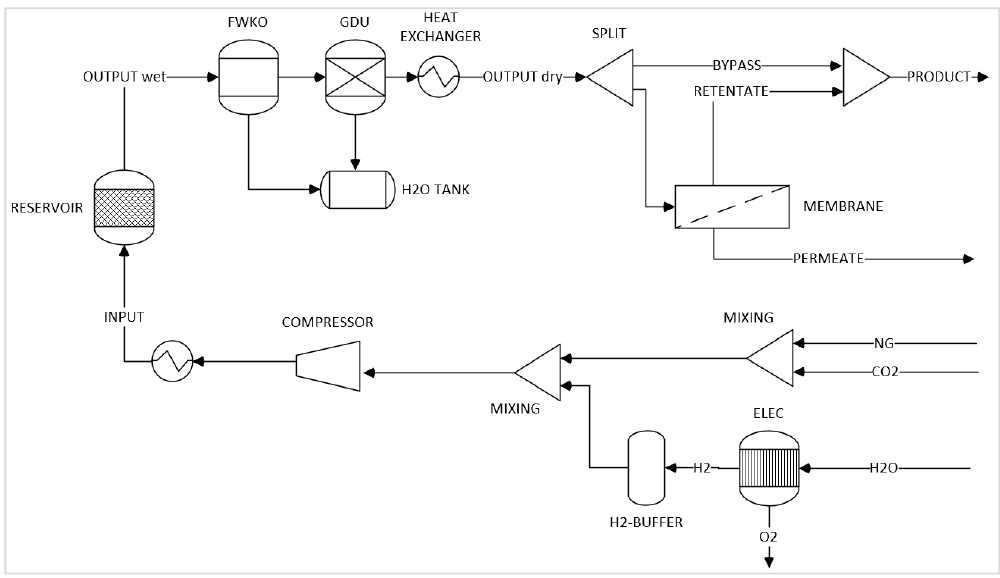
Figure 1. Simplified version of Aspen Plus ® flowsheet for BATCH mode.